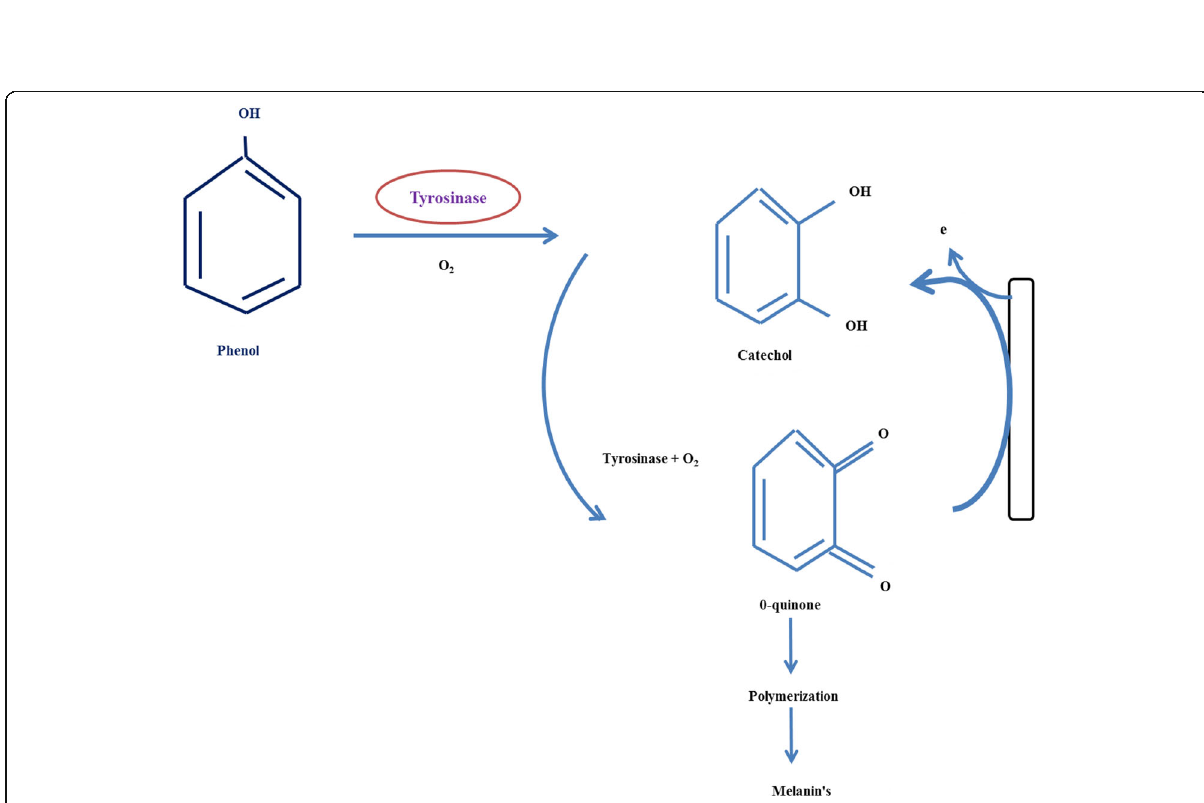
Fig. 5 Mechanism of melanin colour formation in seed aleurone layer using enzyme system upon reaction with phenol